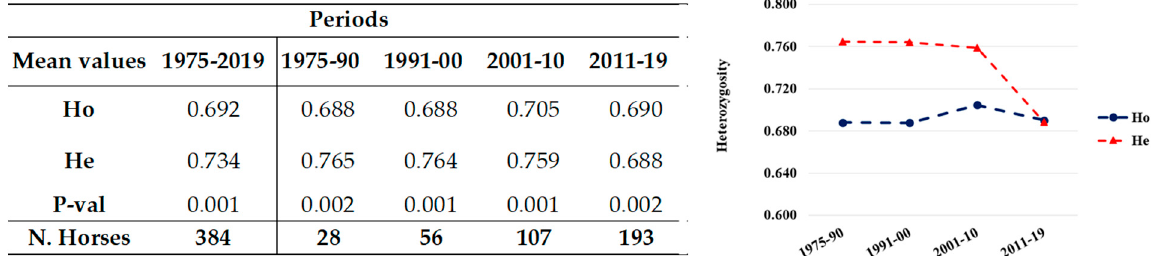
Figure 1. Mean values ( left ) and their plot ( right ) of the observed (Ho) and expected (He) heterozygosity of the total (related and unrelated) population in different periods. The number of horses and the HWE (P-val) per group are reported on the left.